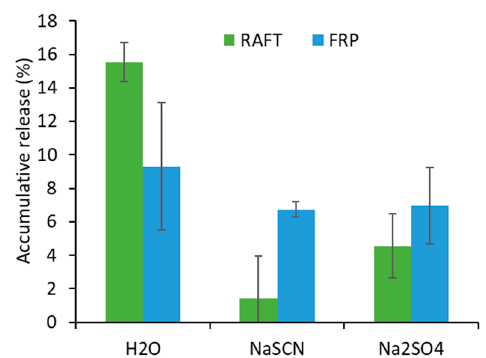
Figure 8. Accumulative release of polymer-bound fluorescein from G2R and G2F after four days in deionized water, 0.1 M NaSCN, and 0.1 M Na 2 SO 4 solutions, respectively.